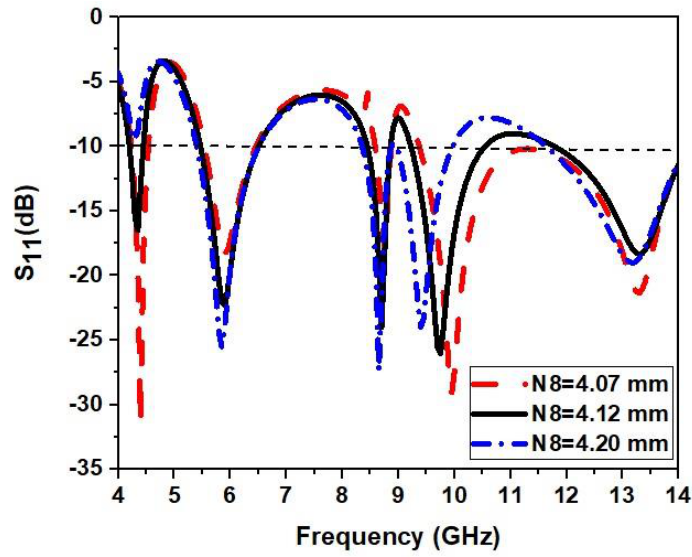
Figure 19. S 11 for variation of length ‘N8’.